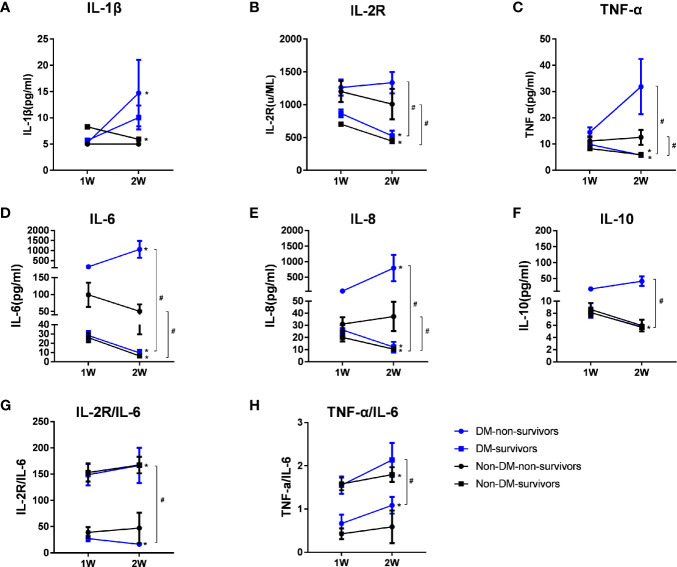
Dynamic changes of serum cytokine levels and Th1/Th2 ratios in groups of diabetic non-survivors, diabetic survivors, non-diabetic non-survivors and non-diabetic survivors from week 1 to week 2. Dynamic changes in Th1 cytokines including IL-1β (A), IL-2R (B), and TNF-α (C); Th2 cytokines, including IL-6 (D), IL-8 (E), and IL-10 (F), and ratios of IL-2R/IL-6 (G) and TNF-α/IL-6 (H) representing the Th1/Th2 ratios from week 1 to week 2 after admission in survivors and non-survivors with COVID-19 infection. Data shown are median (IQR). *represents P < 0.05, week 2 vs. week 1. # represents P < 0.05, non-survivors vs. survivors at week 2 in diabetic or non-diabetic patients. DM, diabetes mellitus.